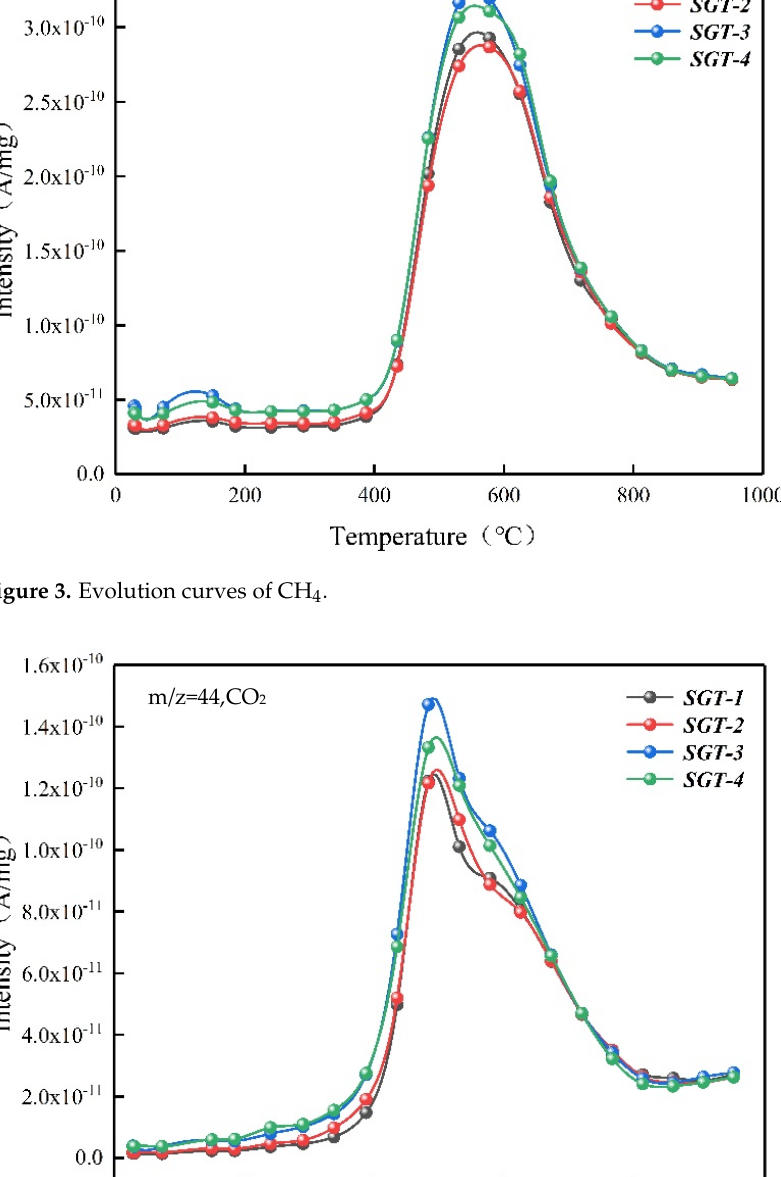
Figure 4. Evolution curves of CO 2.